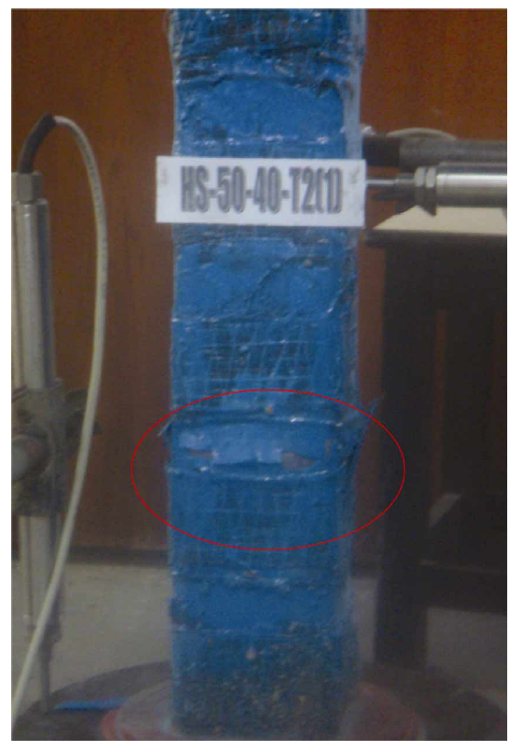
Fig. 8. Failure mode of column HS-50-40-T2(1)